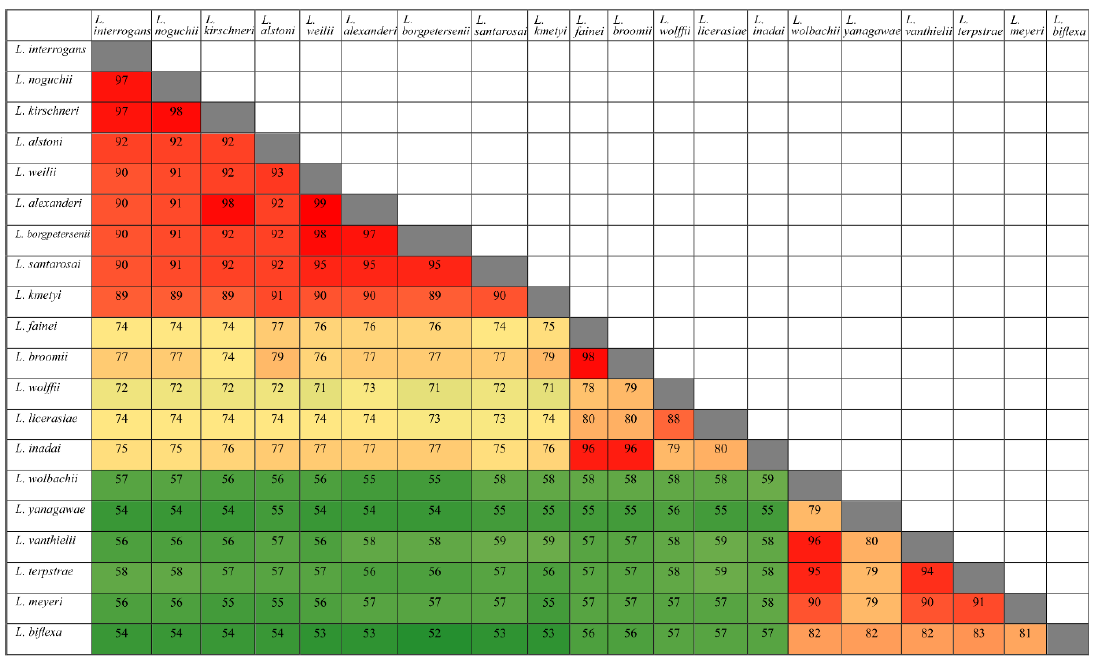
Figure 3. Amino acid sequence identities of LIC20143 from 20 different Leptospira strains. The image was generated comparing the sequence of the protein encoded by LIC20143 from L. interrogans serovar Copenhageni with other 20 species (pathogenic, intermediate, and saprophytic). Similarity is shown in red above 80%, in yellow between 50% and 80%, and in green below 50%.